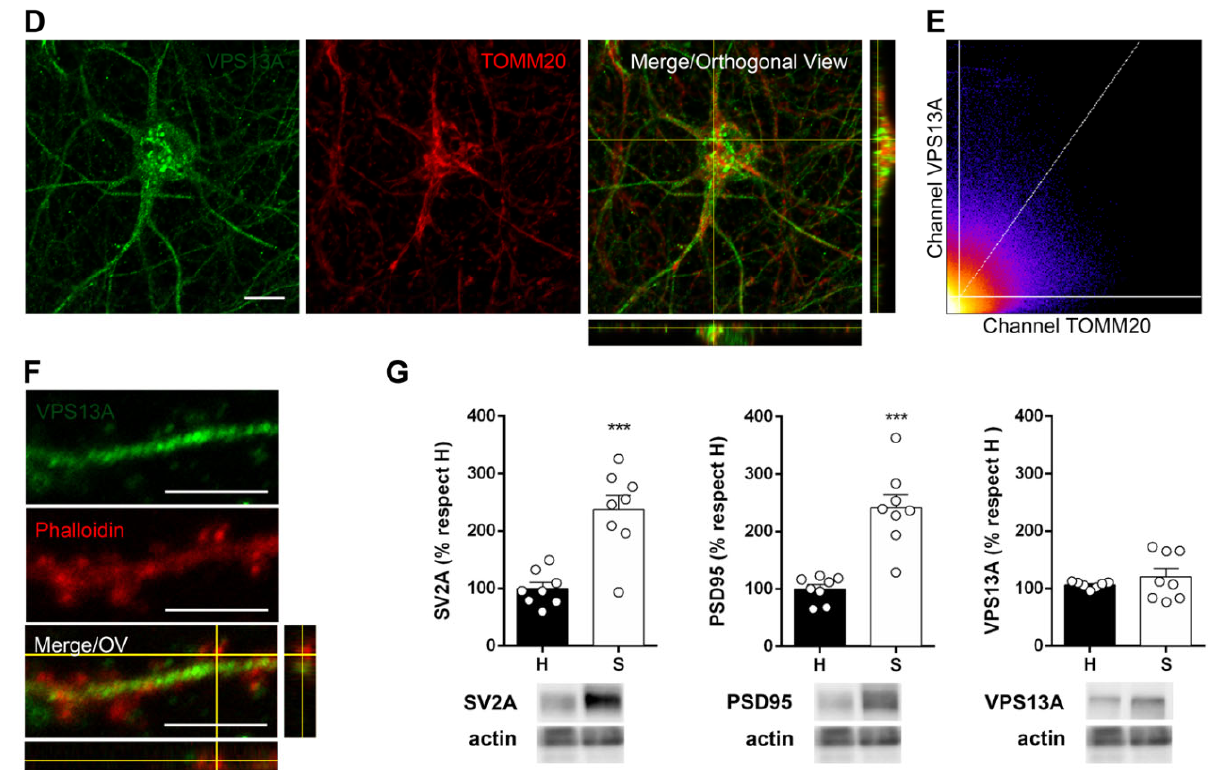
Figure 6. VPS13A is mainly present in the soma of the neurons, colocalizes with endoplasmic reticulum and mitochondria, and is found in synaptosomal fraction lysates. ( A ) Representative confocal images of VPS13A immunostaining in cortical primary neurons. ( B ) Orthogonal view from different planes of representative confocal images of VPS13A/Calnexin colocalization in cortical primary neurons. ( C ) Colocalization scatter plot showing the relationships between the signals in each pixel for VPS13A and Calnexin. ( D ) Orthogonal view from different planes of representative confocal images of VPS13A/TOMM20 colocalization in cortical primary neurons. ( E ) Colocalization scatter plot showing the relationships between the signals in each pixel for VPS13A and TOMM20. Scale bar, ( A , B , D ), 10 µ m; detail in ( A ), 5 µ m. ( F ) Orthogonal view from different planes of representative confocal images of VPS13A/F-Actin localization in cortical primary neurons. Scale bar 5 µ m. ( G ) Homogenate (H) and synaptosomal fractions (S) of mouse cortex were analyzed by Western blot. SV2A (pre-synaptic protein) and PSD-95 (post-synaptic protein) were used as the control for synaptosomal fraction isolation. Actin was used as a loading control. Data representing mean ± SEM and differences were analyzed by Student’s t -test; *** p < 0.001. n = 8 .